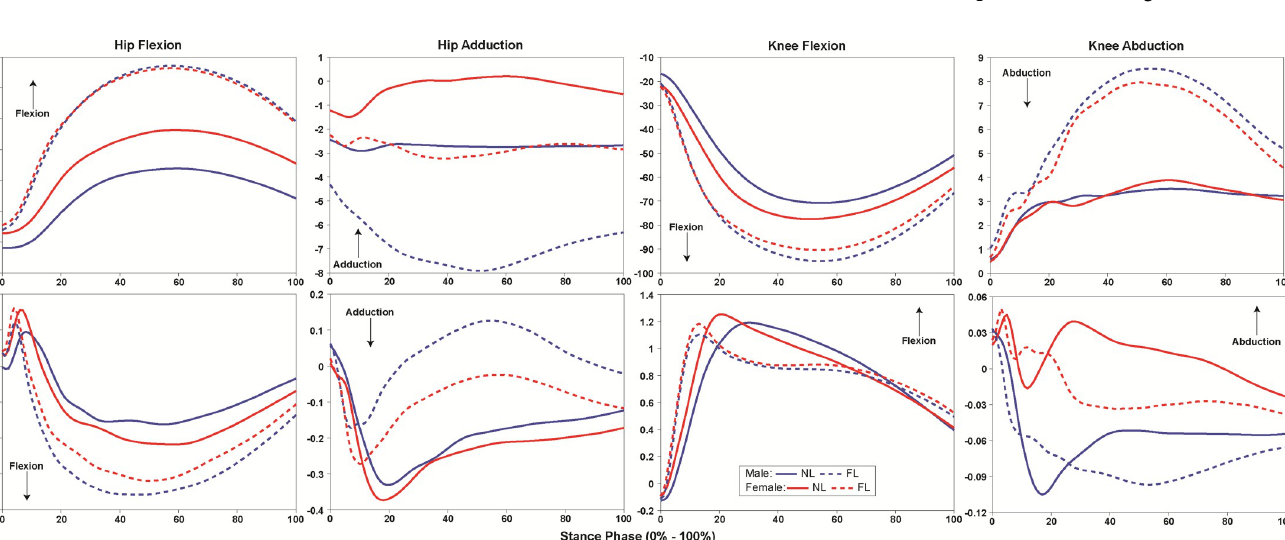
PLOS ONE | https://doi.org/10.1371/journal.pone.0211129 February 6,